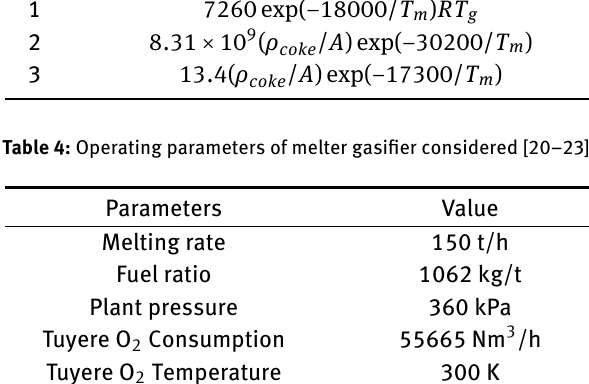
Table 3: Rate constant of heterogeneous reactions n